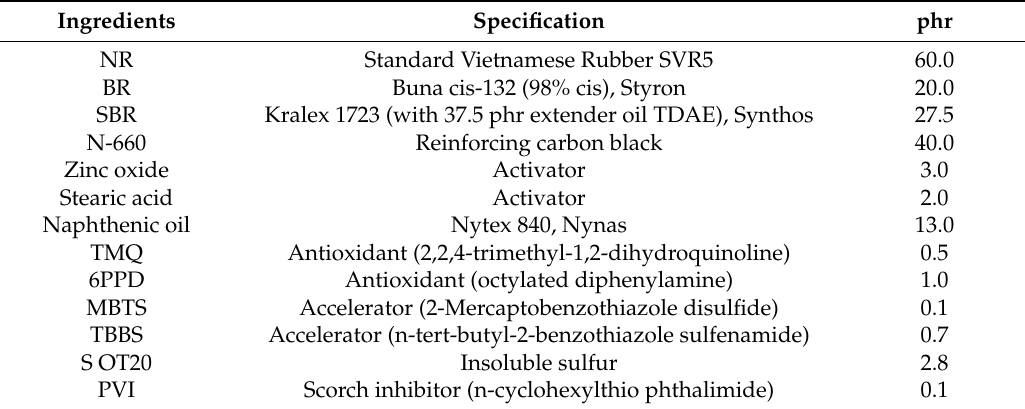
Table 2. Compound for cord adhesion